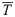
CPU time ratio of the worst (T¯) and the best (T_) choices of basis–insertion-order.Sparsely-connected graphs show a higher sensitivity to the insertion order that those densely-connected.